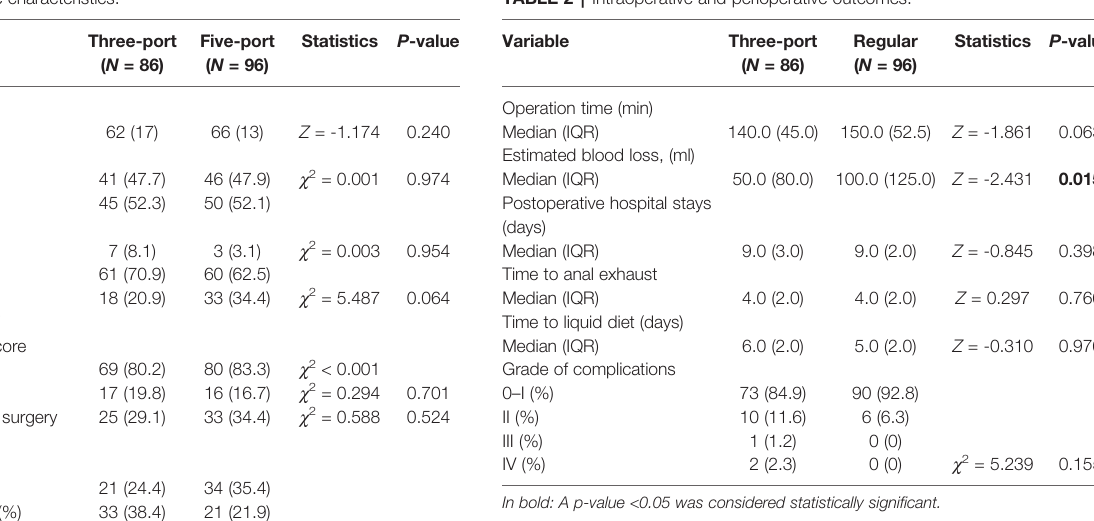
TABLE 1 | Baseline characteristics.